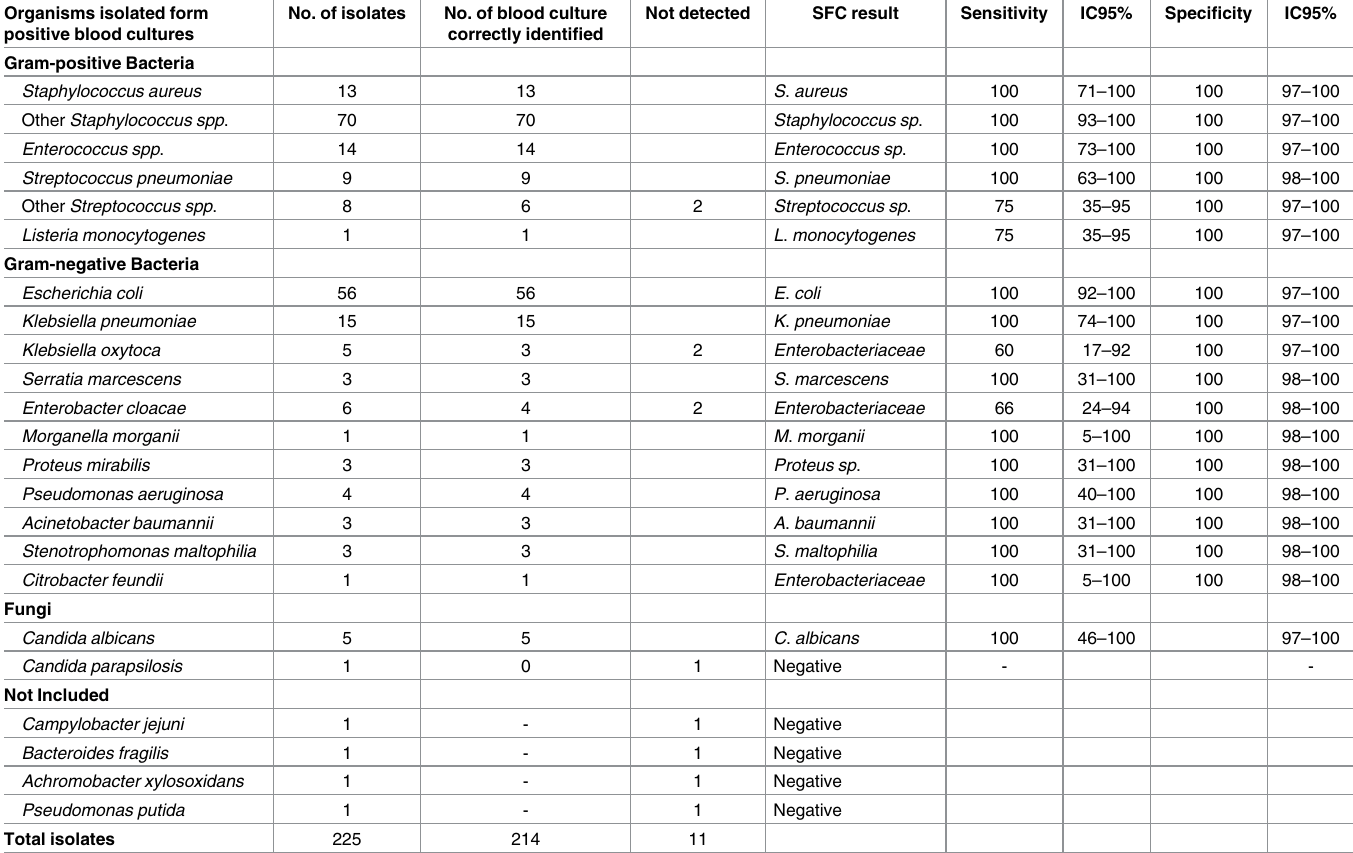
Table 2. Sensitivity and specificity of SFC assay in bacterial identification from positive blood culture samples. Organisms isolated form No. of positive blood cultures